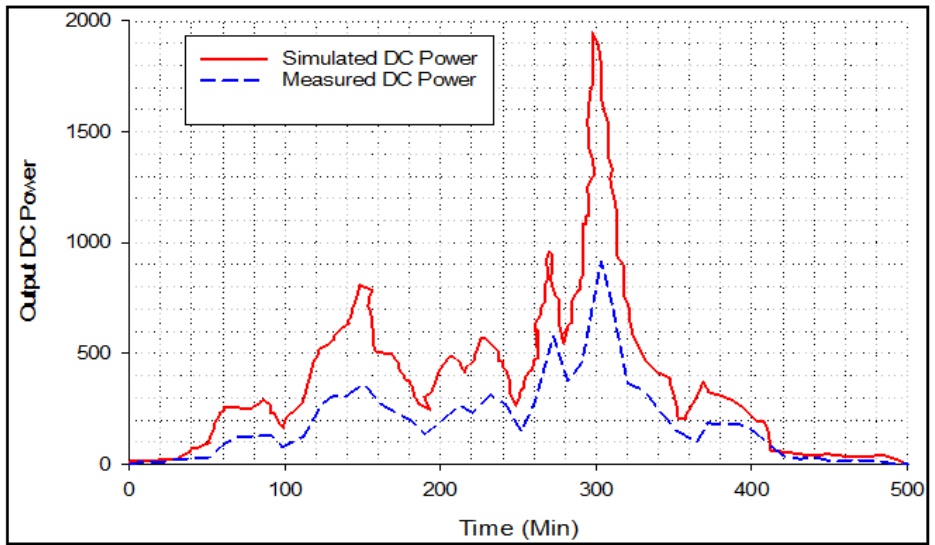
Figure 8. DC simulated power versus measured power (open-circuit fault operation).